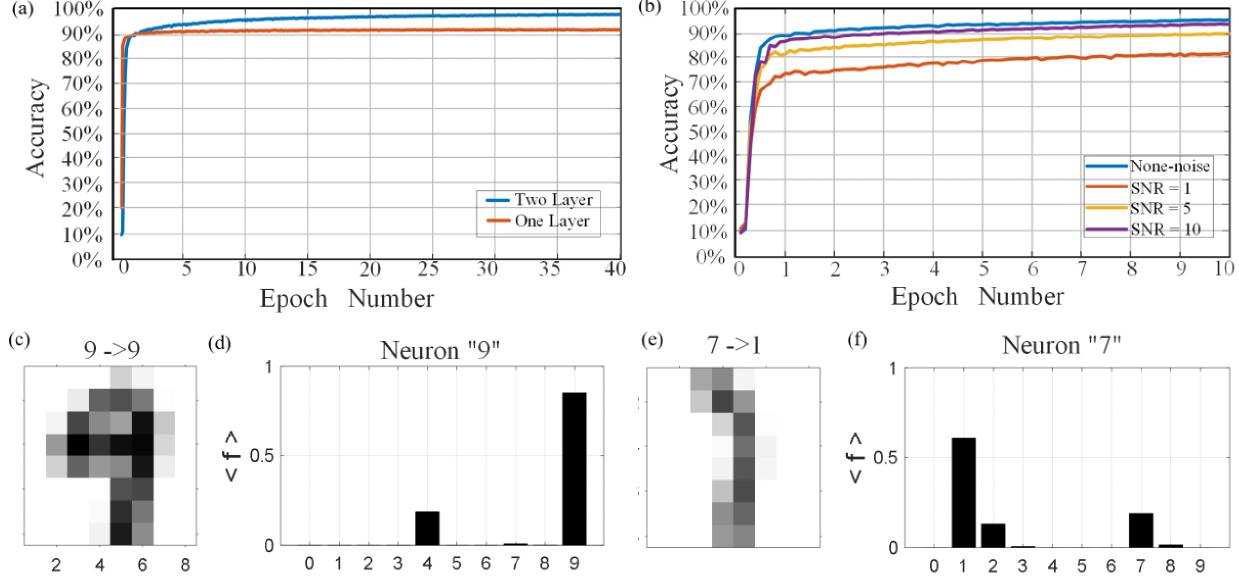
Figure 7. Training results. ( a ) Recognition accuracy in response to neural network structure with different layer numbers. ( b ) The recognition accuracy of the neural network with the same structure under different signal-to-noise ratios. ( c , d ) Correctly classified digit “9” and ( e , f ) misclassified digit “7”.